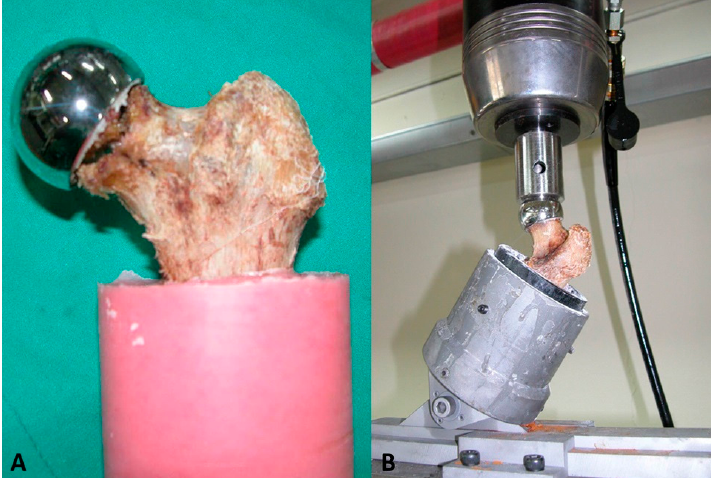
Figure 3. The preparation of the femoral specimens. ( A ) The femoral specimen was inserted in the resin block along the anatomical axis. ( B ) The femoral specimen with the femoral head implant was placed in a custom-made jig for the loading–unloading test.